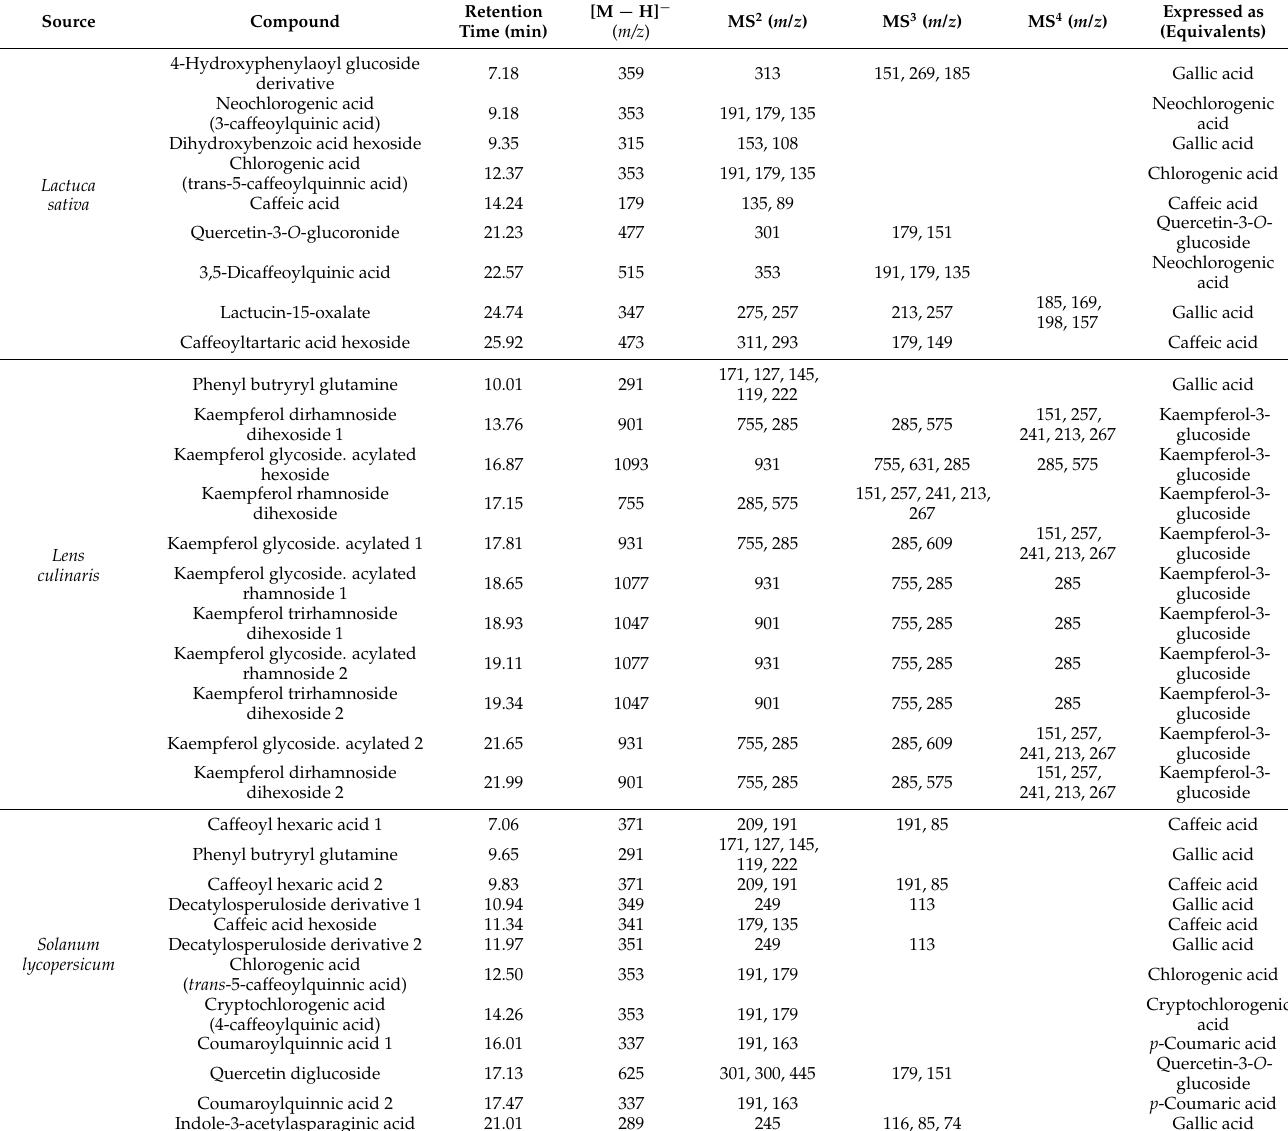
Table 1. Tentative identification of phenolic compounds of Lactuca sativa L., Lens culinaris Medik. and Solanum lycopersicum L., and compounds used as standard equivalents. Compounds for which no standards were obtained are identified according to literature